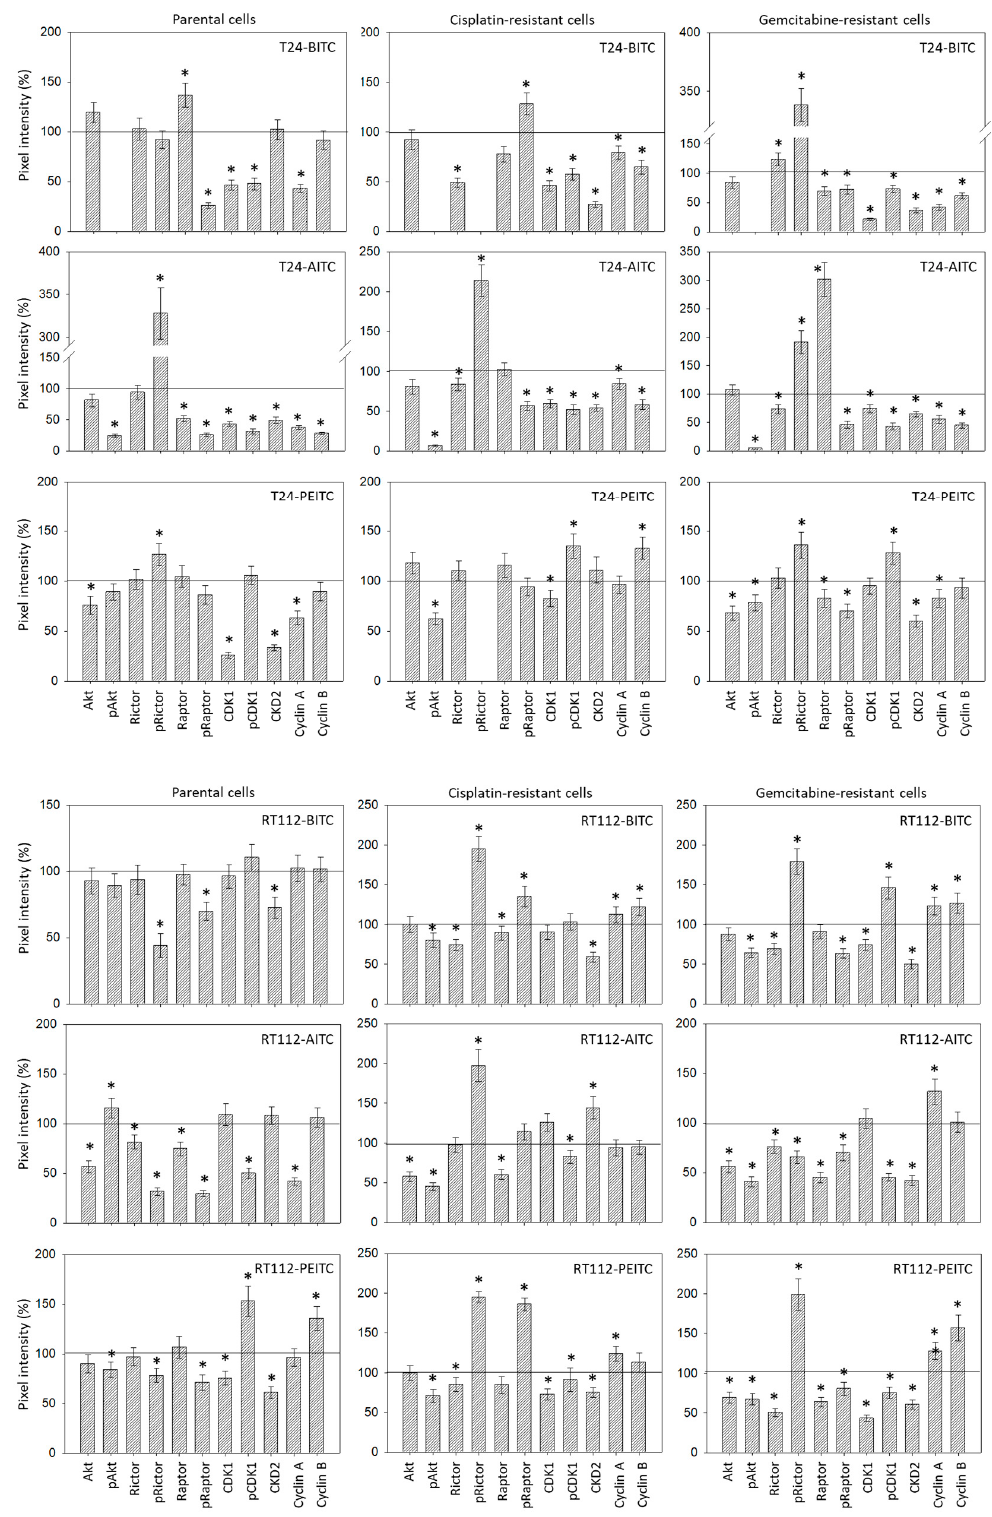
Figure 9. Pixel density analysis of the protein level in the sensitive and resistant bladder cancer cell lines cells following SFN treatment. Values are given in percentage, related to the 100% control (indicated by a black line). * significant difference to controls.